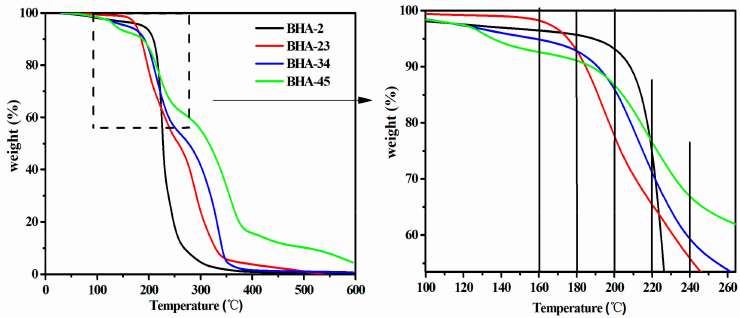
Figure 3. Thermogravimetric analysis (TGA) curves of four BHAs.